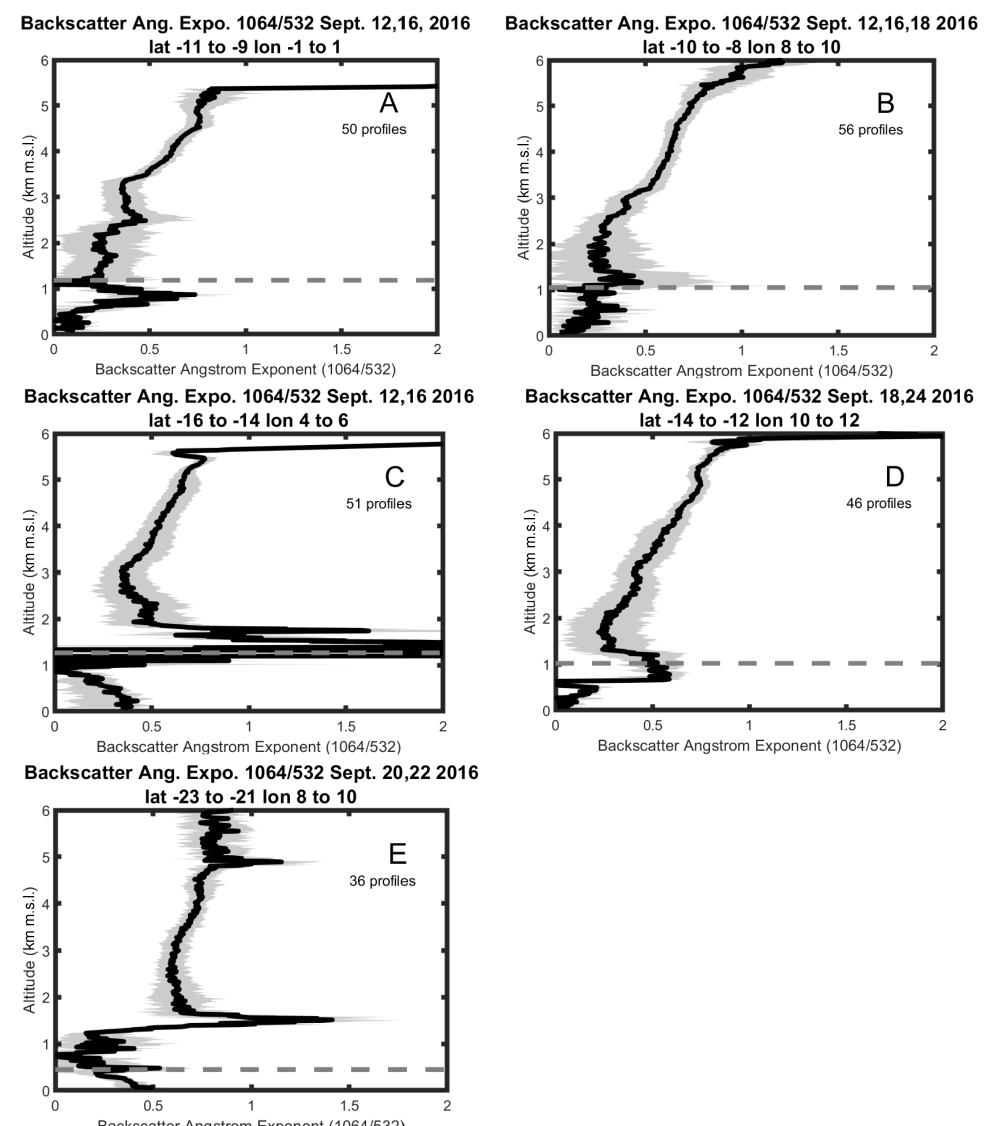
Figure 7. As in Fig. 6 but for the wavelength-dependent backscatter Ångström exponent between 1064 and